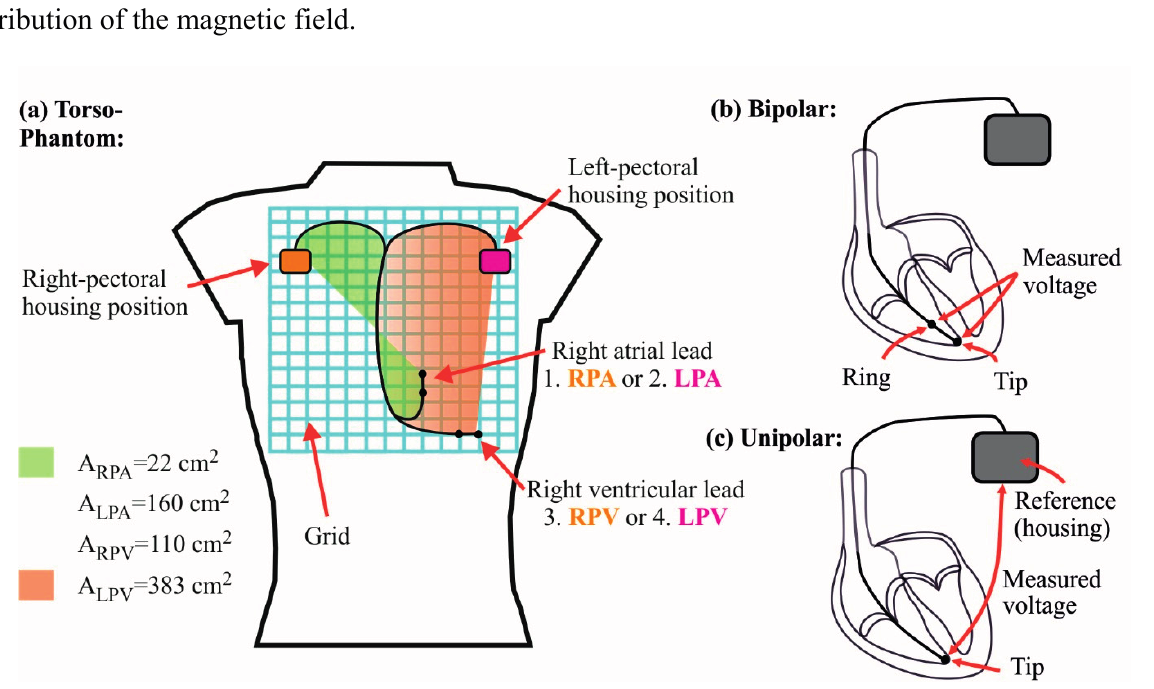
Figure 1. ( a ) Schematic diagram of the torso phantom. All implantation sites are indicated: 1. Housing: right-pectoral. Lead: atrium (RPA). 2. Housing: left-pectoral. Lead: atrium (LPA). 3. Housing: right-pectoral. Lead: ventricle (RPV). 4. Housing: left-pectoral. Lead: ventricle (LPV).The green area marks the unipolar induction area for the RPA implantation site (A RPA ). The orange area marks the unipolar induction area for the LPV implantation site (A LPV ). A RPV and A LPA are the unipolar induction areas of the implantation sites RPV and LPA. ( b ) Sensing mechanism of a bipolar lead. A differential (the housing is the reference electrode) voltage is measured between tip and ring electrode. ( c ) Sensing mechanism of a unipolar lead. A voltage is measured between tip and the reference (housing)